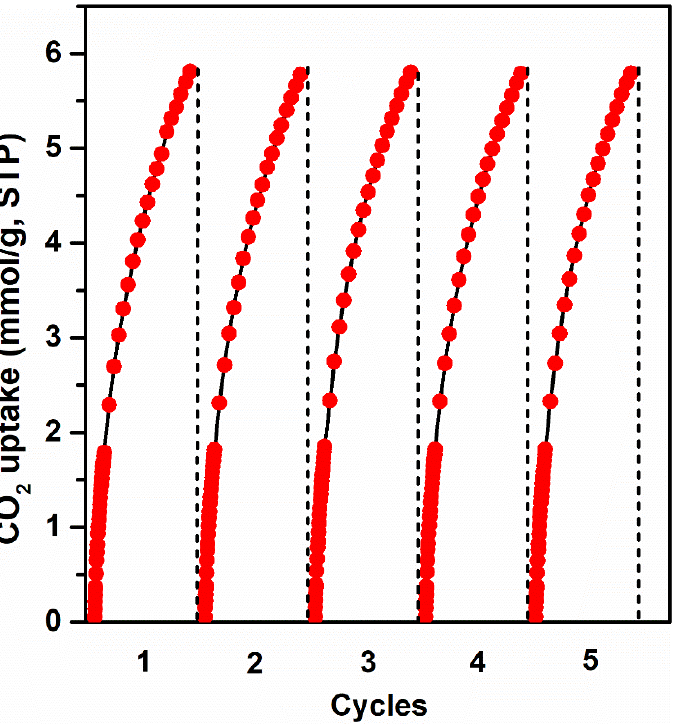
Figure 12. Five consecutive adsorption–desorption cycles of NPC-600-4 at 273 K.